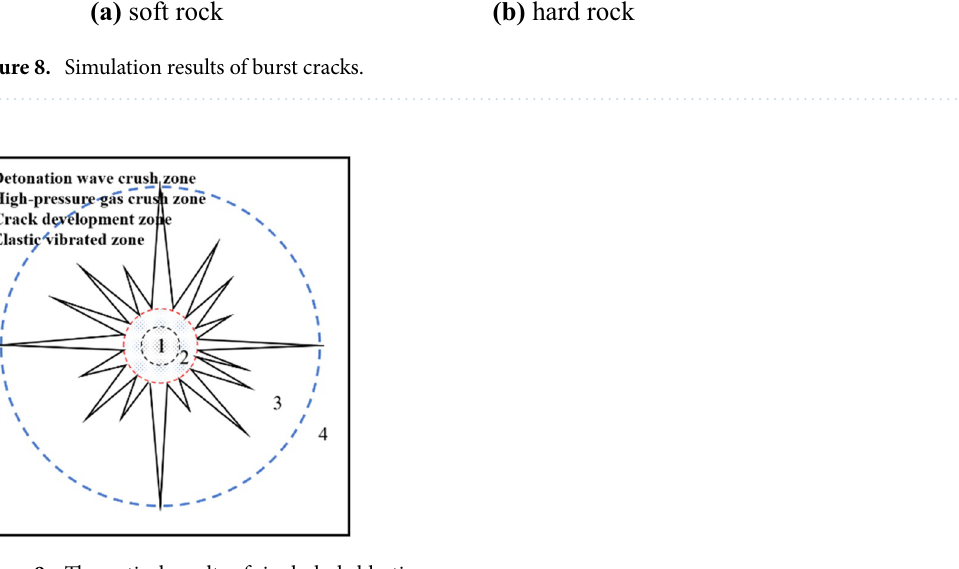
Figure 9. Theoretical results of single-hole